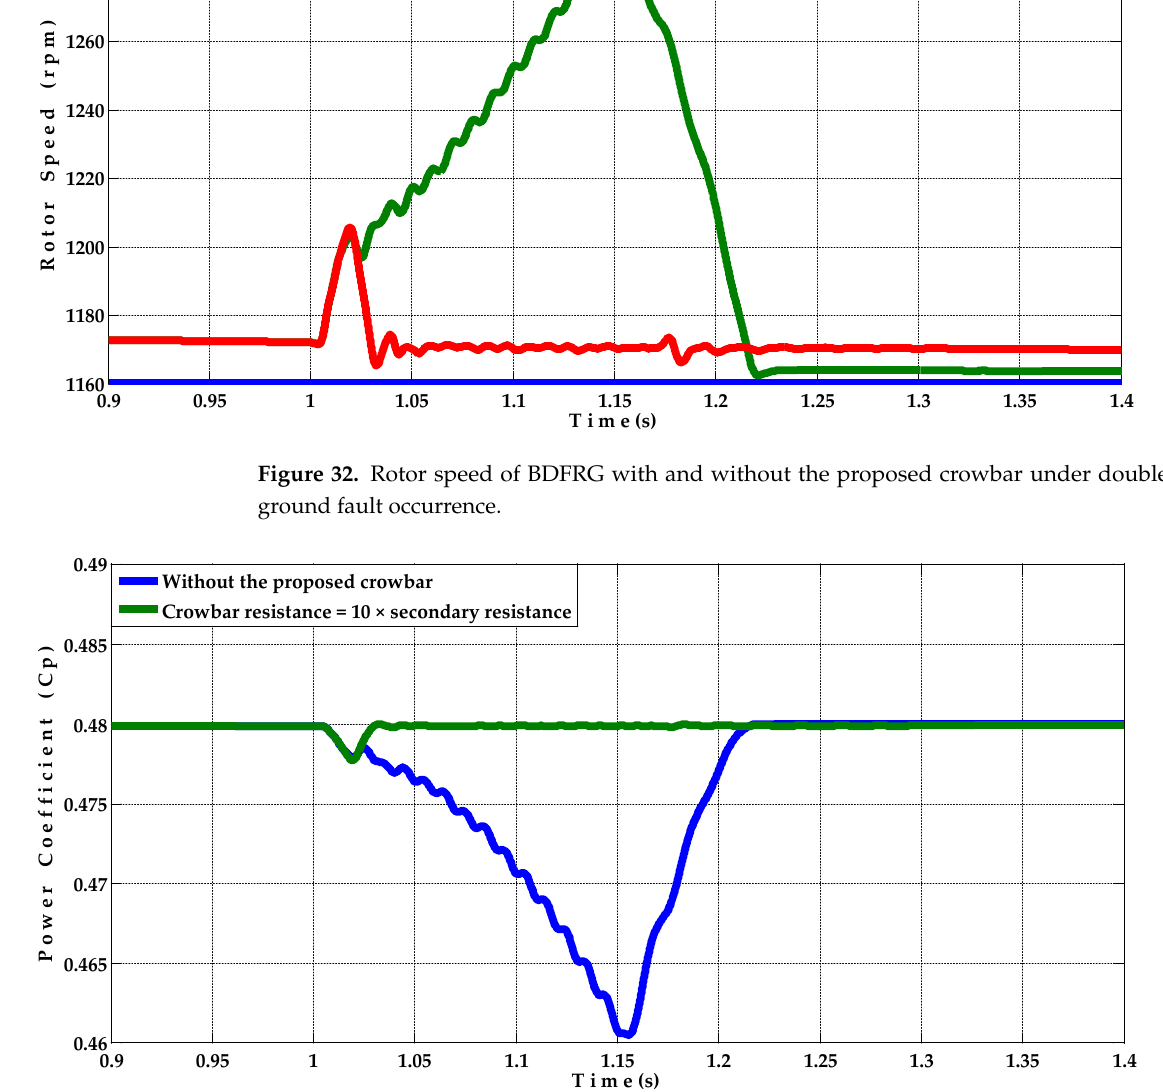
Figure 33. Power coefficient of wind turbine with and without the proposed crowbar under double line to ground fault occurrence.